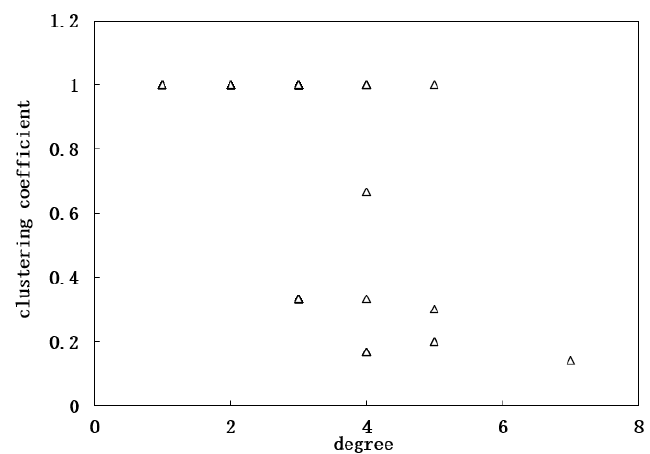
Figure 6. The relationship of the node and the clustering coefficient.